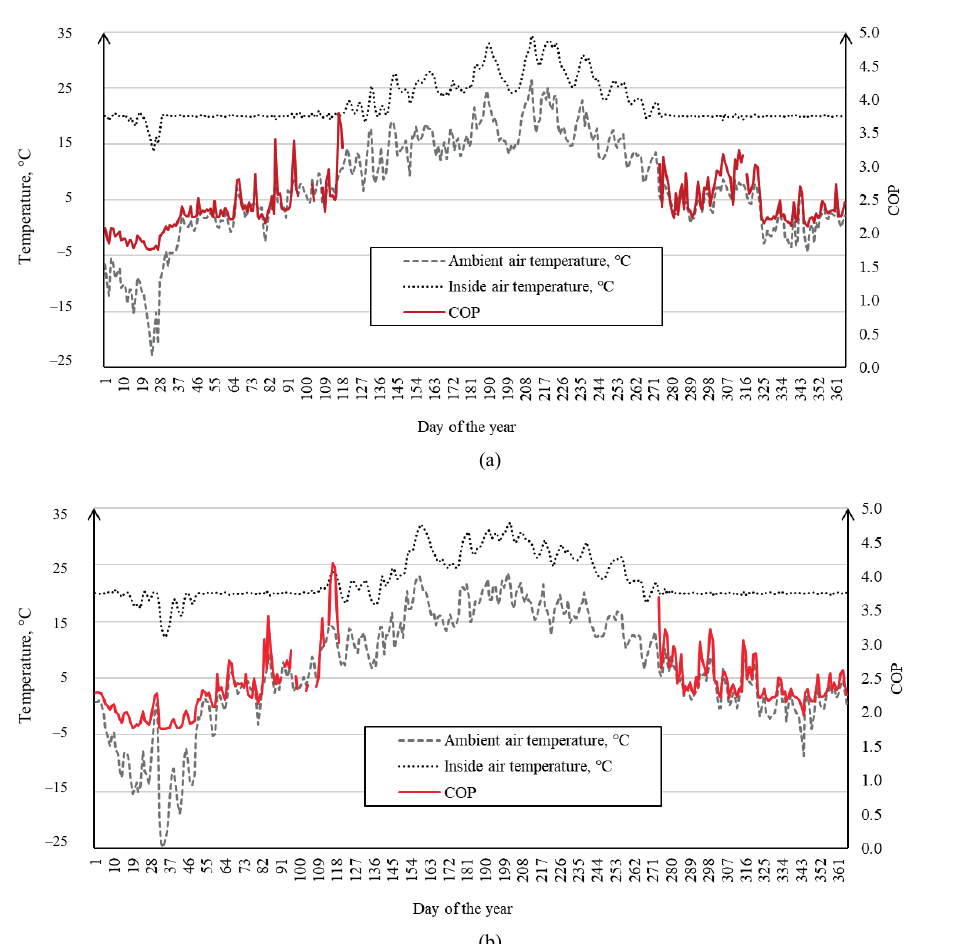
Fig. 6. COP dependence on ambient air temperature in: a) Riga and b)